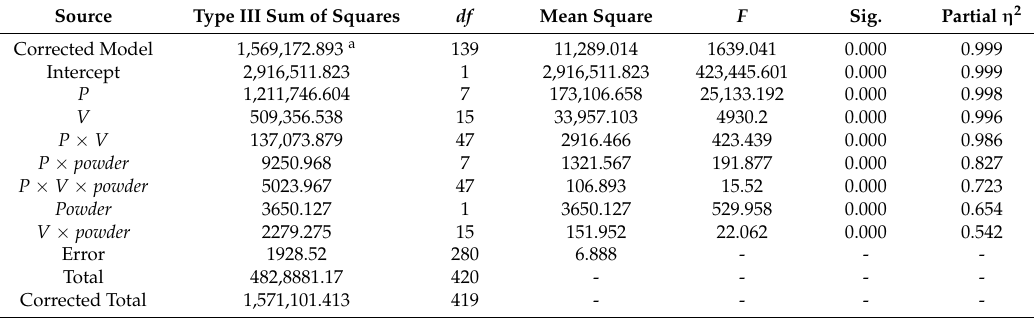
Table 3. Univariate analysis of variance, tests of between-subjects effects: the penetration depth.